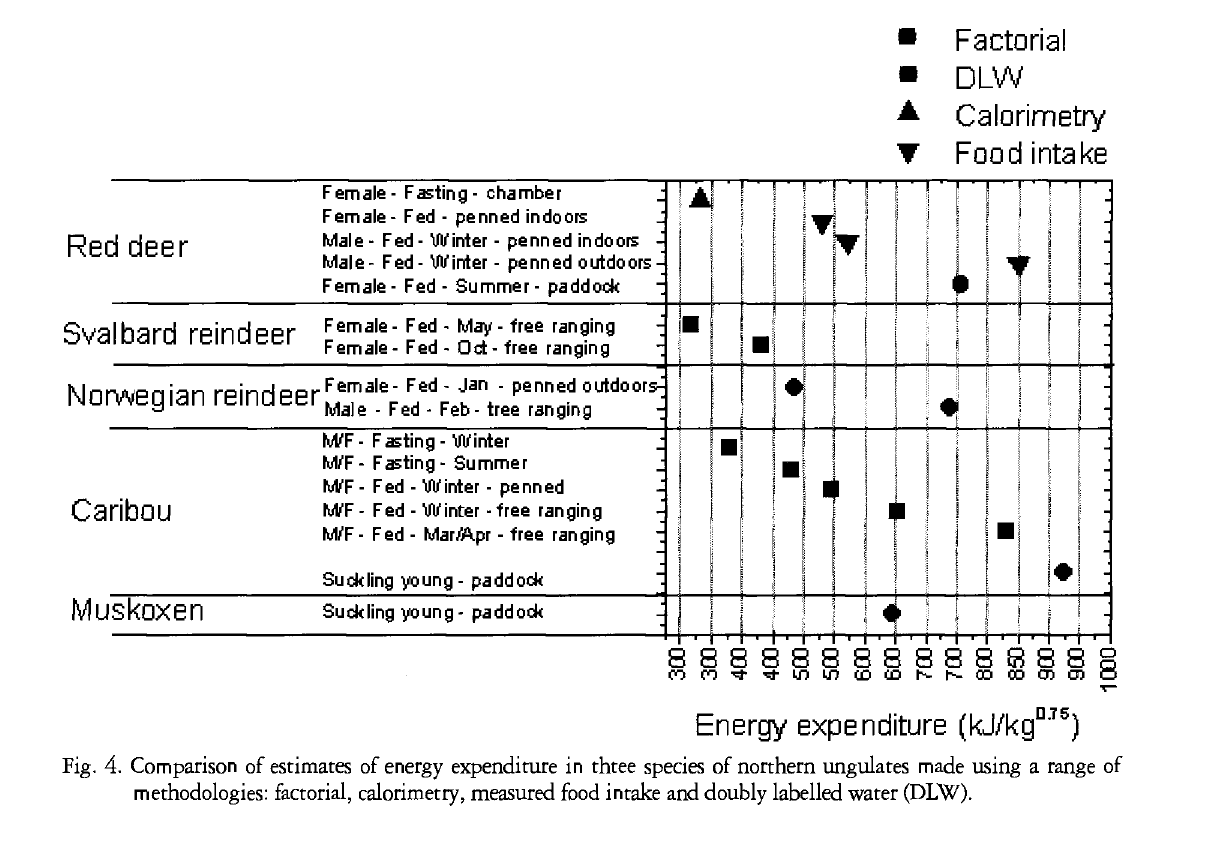
Fig. 4. Comparison of estimates of energy expenditure in thtee species of northern ungulates made using a range of methodologies: factorial, calorimetry, measured food intake and doubly labelled water